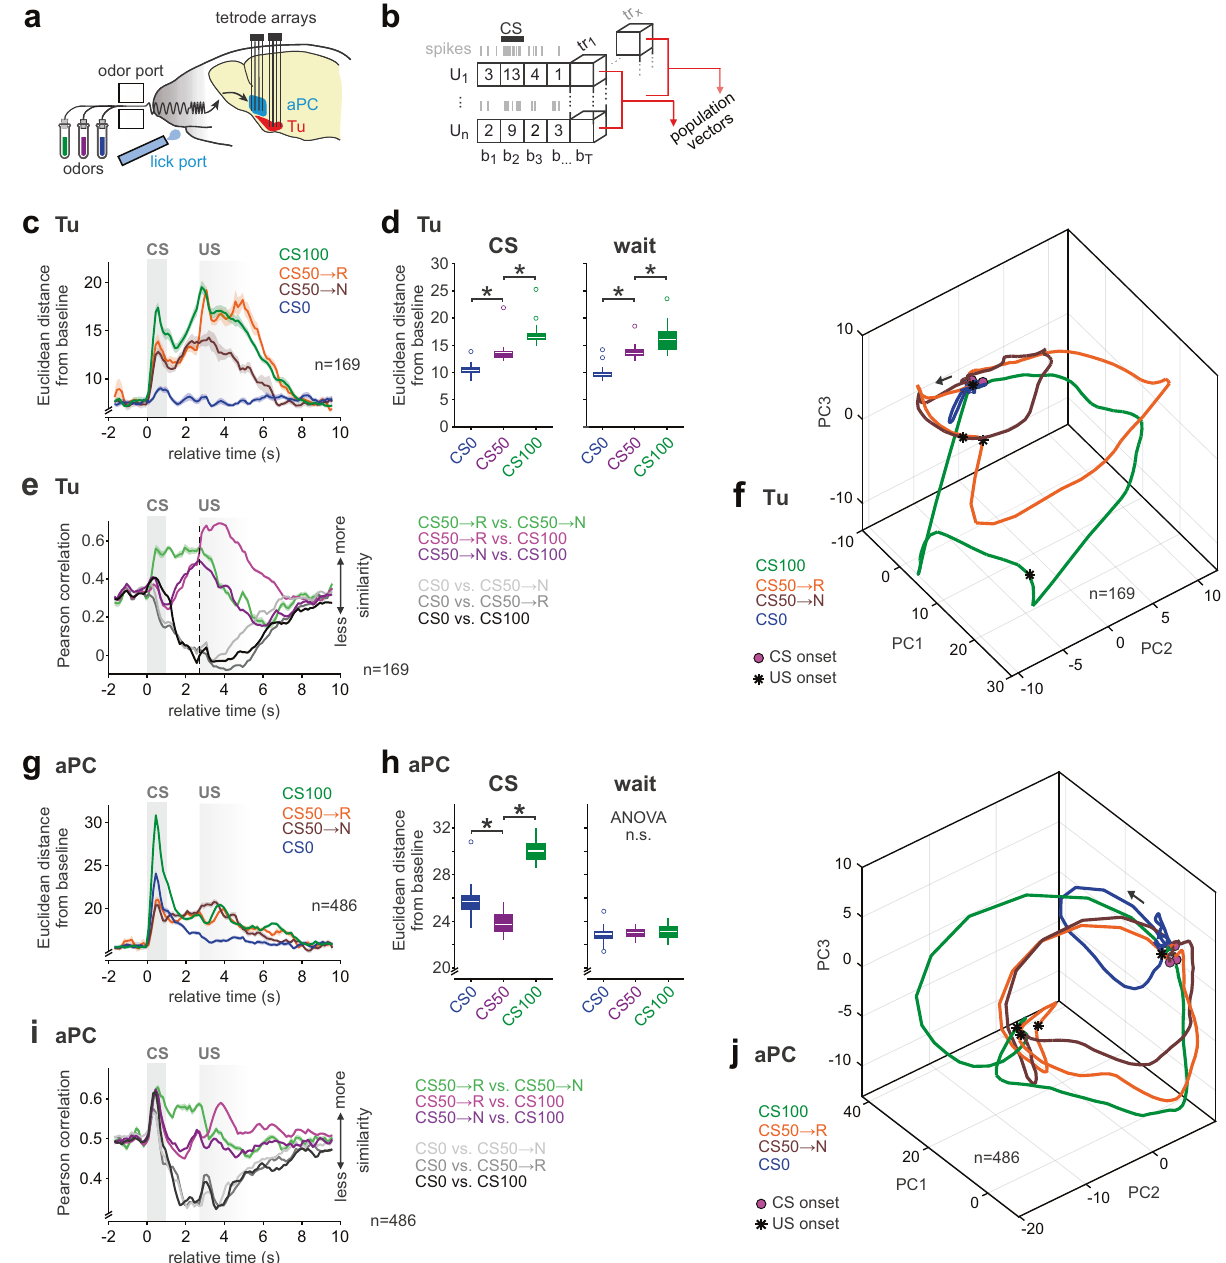
Fig. 5 Task-related neuronal population coding in the olfactory cortex and striatum. a Con fi gurations of the dual-site single-unit recordings. Custom- made tetrode arrays were implanted into the Tu and aPC. Mice performed the same stimulus-outcome-associated task in head- fi xed con fi guration as in the (cid:1) (cid:3) scanner. b Population vectors were constructed by concatenating the binned spike counts of individual single units U 1 ; ¼ ; U n pooled across sessions by matching trial bin b i , trial order tr j , and trial type. c The Euclidean distance of Tu population vectors from baseline displayed an RP coding at CS and during the waiting period, as well as reward coding at US. Displayed mean ± SEM, 500 ms bins slid in steps of 125 ms. d Euclidean distance from baseline during CS (from 0 to 1 s) and waiting window (from 1 to 2.5 s). One-way ANOVA with Tukey post hoc comparisons performed separately in each window ( n = 169 units). e Pearson correlation between Tu population vectors displayed as mean across pairs of trials ± SEM. The population responses to CS100 and CS50 became more similar during wait, suggesting a partial overlap in Tu units coding for the two stimuli. f First three principal components of the time-embedded averaged trajectories of Tu during different trial types. The arrow marks the direction of the temporal evolution. Reward delivery abruptly de fl ected the population trajectories of CS50 → R and CS50 → N. g , h Same as ( c , d ) for aPC. aPC population displayed a dominant response to all CS, but no monotonic RP coding ( n = 486 units). i Same as ( e ) for aPC. The similarity between aPC population response to all stimulus onsets is consistent with a sensory detection signal. j Same as ( f ) for aPC. Also aPC population trajectories re fl ected an initial indiscriminate sensory detection signal. In the fi gure: * indicates P < 0.05 (see Supplementary Table 1 for exact P values and test details) and n indicates the number of units. Box plots: The bounds of the box represent 25th to 75th percentiles. The center indicates the median. The lower and upper whiskers represent the minimum and maximum values without outliers; outliers indicated by circles. Source data are provided as a Source Data fi le.